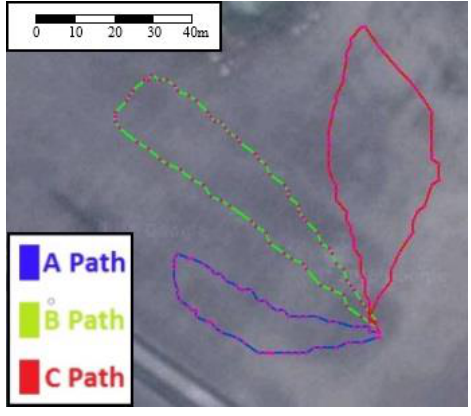
Figure 14. Experimental Trajectory When the Maximum Distance Limit Is 164 m.